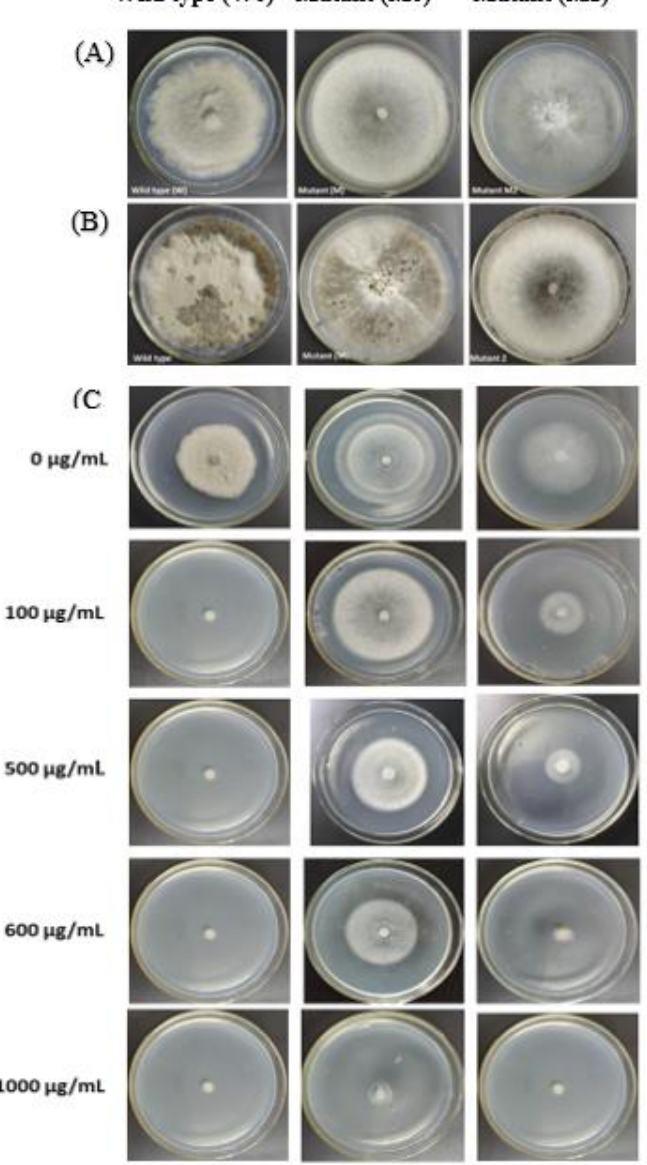
Figure 2. Colony morphology of B .c inerea Wild type (W0) and its mutant (M0, M2); ( A ) Mycelial growth of mutants (M0, M1) and its wild type on PDA medium after 5 days; ( B ) Sclerotia formation of wild type (W0) and its mutants (M0,M1) on PDA medium after 8, 12 and 14 days respectively; Sporulation: mean number (× 10 6 ) seclerotia per square centimeter, ( C ) Mycelial growth of wild type (W0) and its mutants (M0, M1) after exposed 100, 500, 600 and 1000 µg/mL to iprodione on PDA medium at 28 °C for 3 days.